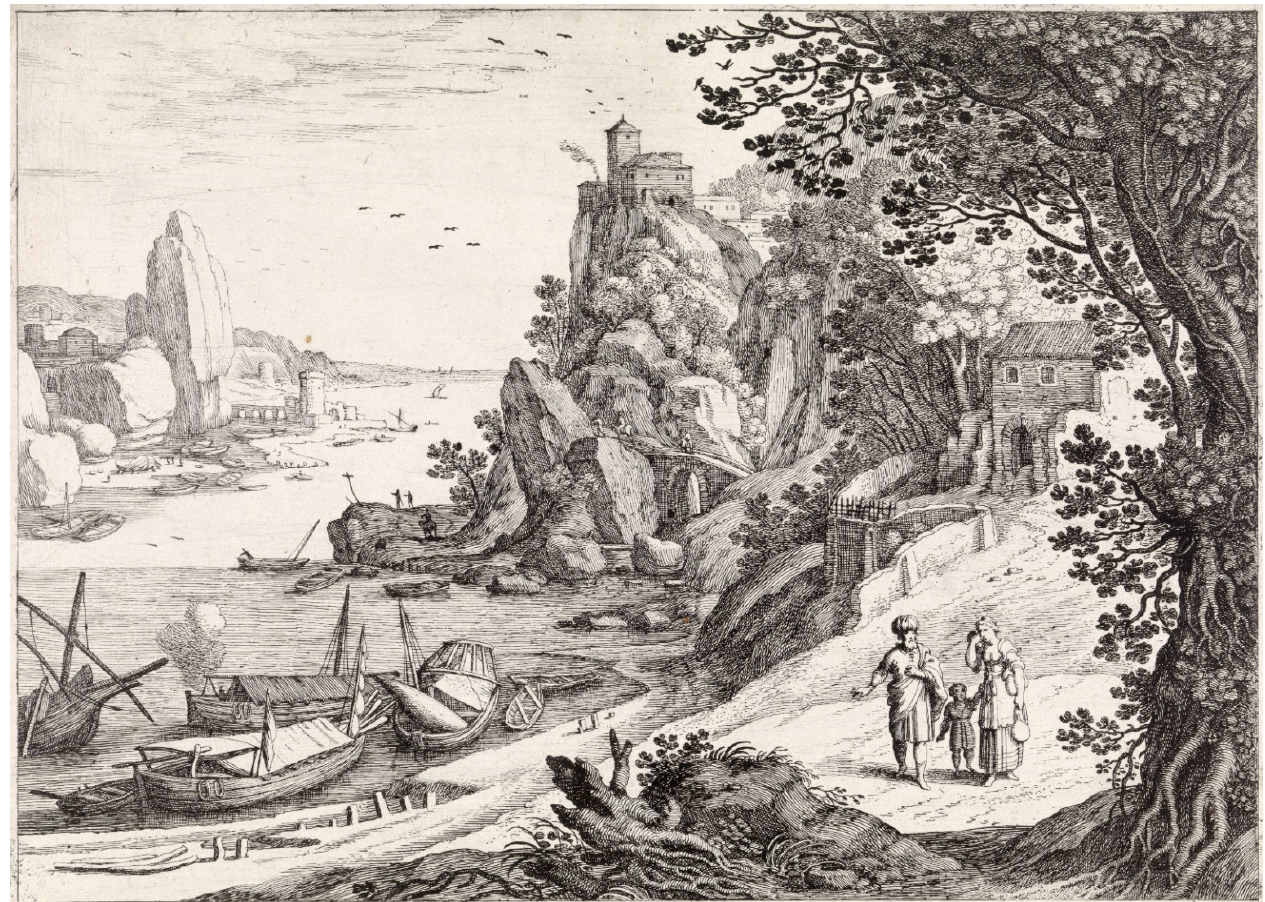
Figure 10. Willem van Nieulandt II, 1594–1685. Amsterdam, Rijksmuseum, RP-P-1895-A-18944. In the Dutch sphere, in the 17th century, Pieter Lastman created an artwork (1612, Hamburg, K) (Figure 11) with an atmosphere of fantasy in the landscape and characters in fine Eastern-styled clothing, a crying Ishmael carrying a piece of bread under his arm as Abraham sees them off to their fate. In the background, Sarah holds her baby in the midst of a domestic scene with servants and animals, showing the good state of the household. 18 Artistic creativity has sometimes gone beyond conventionality, even creating new types as in the case of a canvas by Willem Batsius (1631, London, Sotheby’s, 9 December 2010) (Figure 12) in which Abraham begs an evasive Sarah in vain for compassion for Hagar and her son.